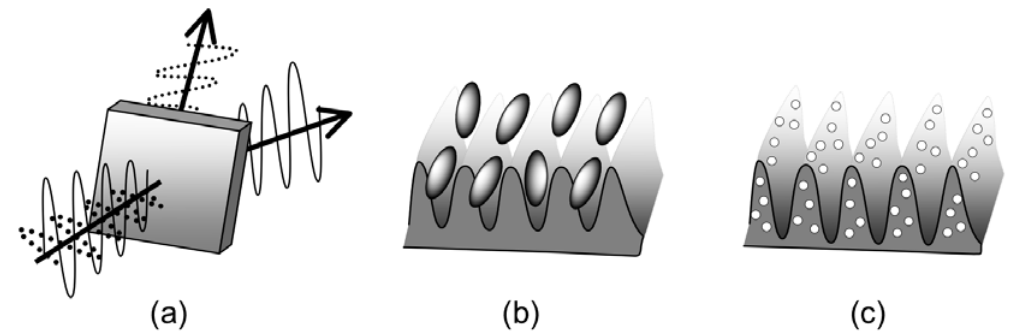
Figure 13. Schematics of several applications of PSRs ( a ) optical; ( b ) geometrical; and ( c )